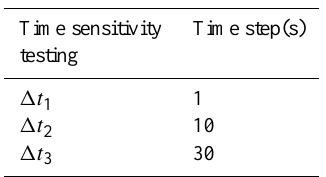
Table 2. Scenarios of time sensitivity